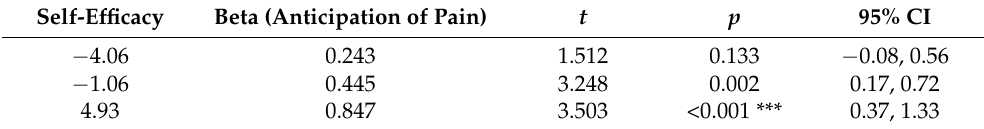
Table 4. Conditional effects of anticipation of pain on avoidance at values of self-efficacy. Self-Efficacy Beta (Anticipation of